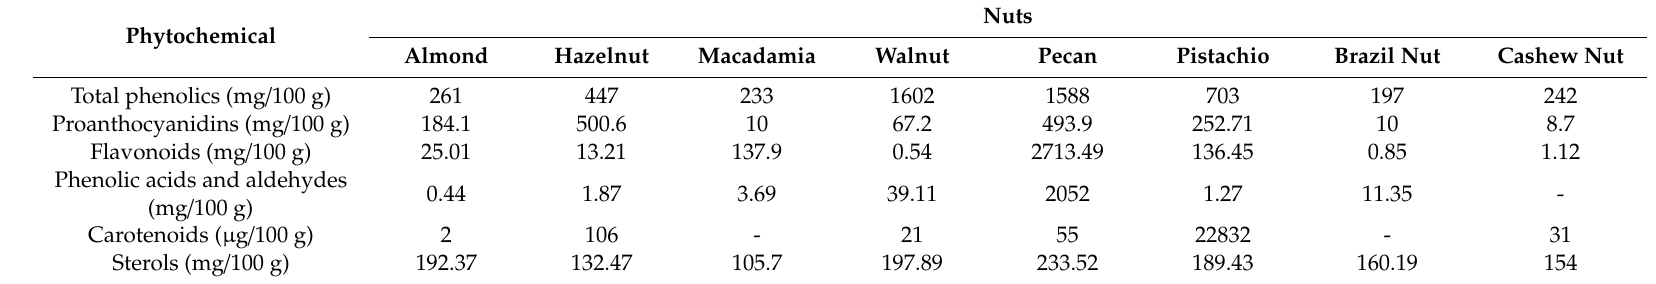
Table 2. Phytochemical content of